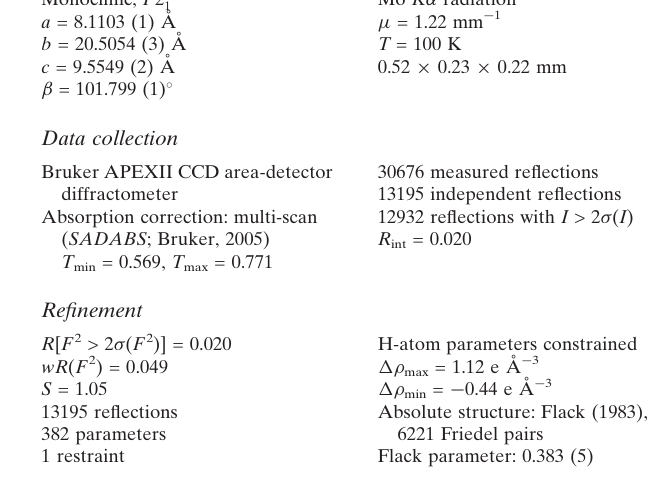
Data collection Bruker APEXII CCD area-detector diffractometer Absorption correction: multi-scan ( SADABS ; Bruker, 2005)